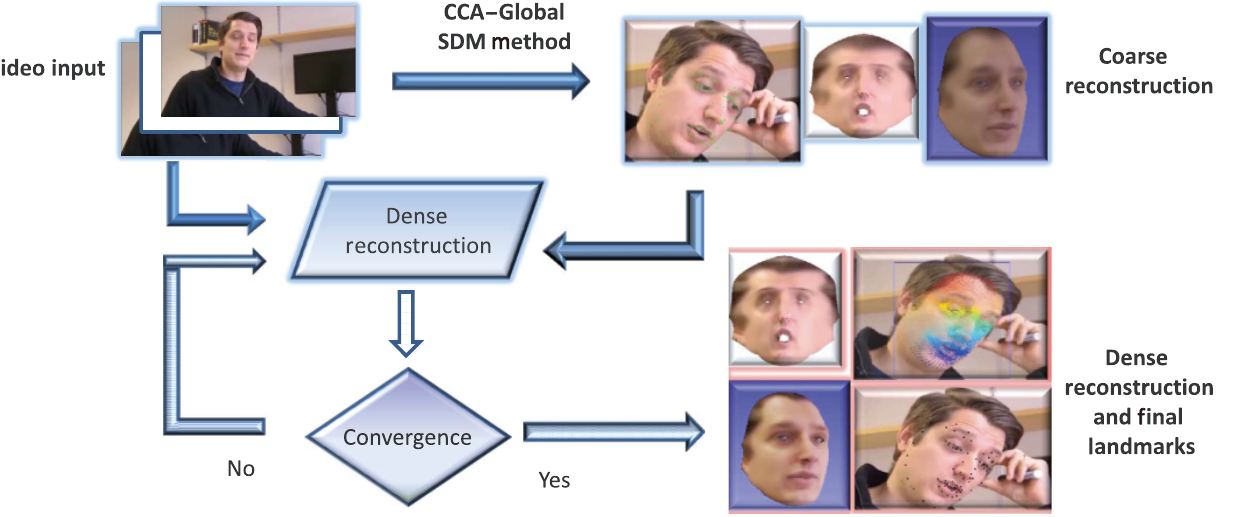
Fig. 1 Flowchart of our